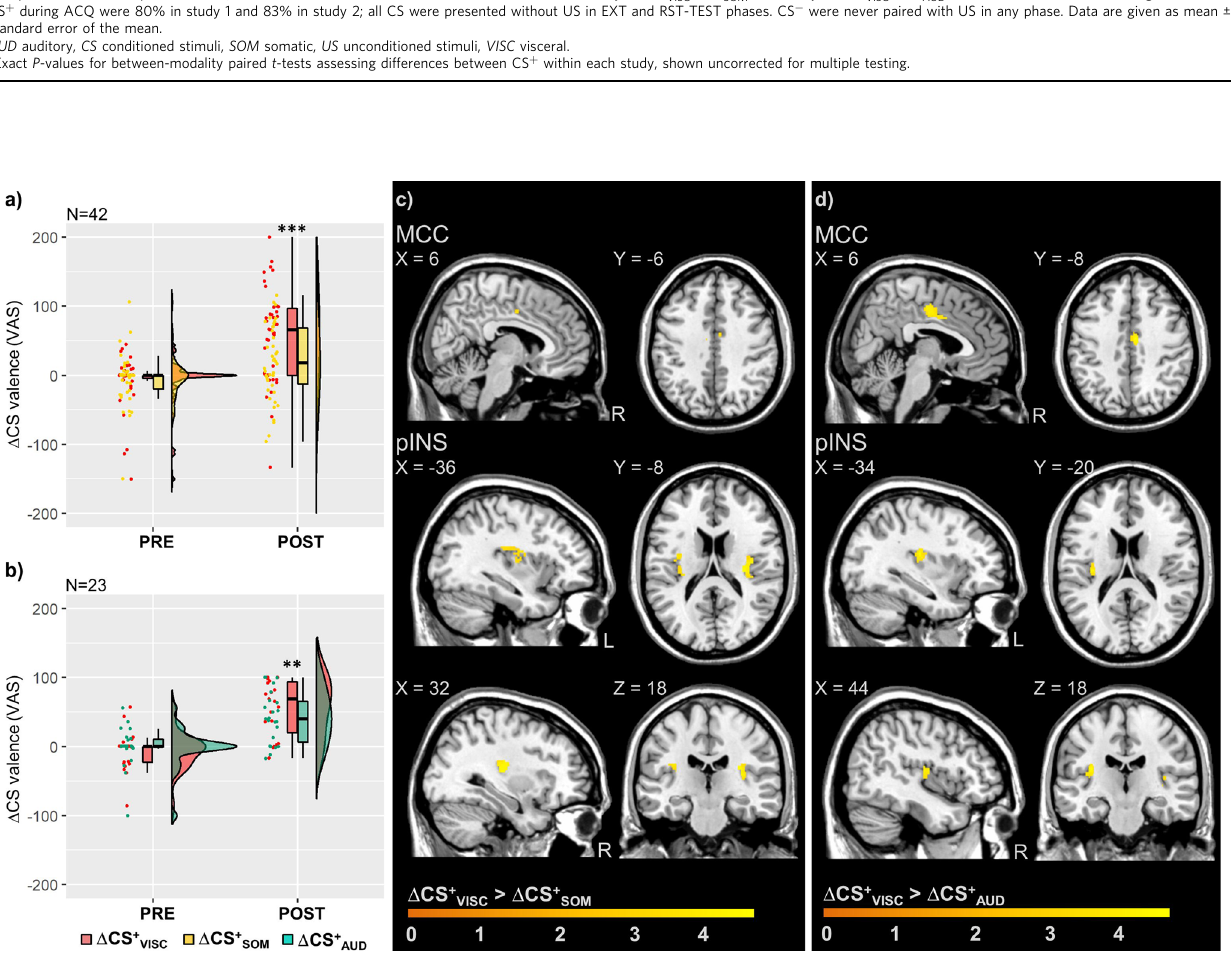
Fig. 2 Behavioural and neural responses to cues (CS) predicting interoceptive versus exteroceptive threats during acquisition in studies 1 and 2. Conditioned predictors of interoceptive threat ( Δ CS + VISC ) acquired signi fi cantly greater negative valence than conditioned predictors of exteroceptive threats after acquisition a study 1, compared to Δ CS + SOM : *** P < 0.001; b study 2, compared to Δ CS + AUD : **P < 0 . 01; results of Bonferroni-corrected paired t-tests between modalities, full details in Supplementary Tables S4 – S7. Individual delta ( Δ ) scores were computed for differential CS valence of each CS + relative to the CS − . Data are presented as individual data points, boxplots, and densities (raincloud plots 117 ). At the neural level, interoceptive threat predictors ( Δ CS + VISC ) induced enhanced differential neural responses in MCC and pINS compared to both exteroceptive threat predictors c study 1, Δ CS + Δ CS + Δ CS + Δ CS + P VISC > SOM ; d study 2, VISC > AUD ; all FWE < 0.05; details in Table 3, but threat predictors also induced shared differential activation in overlapping brain regions across studies (full results in Supplementary Table S8). For whole-brain results, see Supplementary Fig. S5. Neural activations in regions of interest were superimposed on a structural T1-image and thresholded at P < 0.001 uncorrected for visualisation purposes; colour bars indicate t -scores. AUD auditory, CS conditioned stimuli, FWE family-wise error, MCC midcingulate cortex, pINS posterior insula, SOM somatic, VAS visual analogue scale, VISC